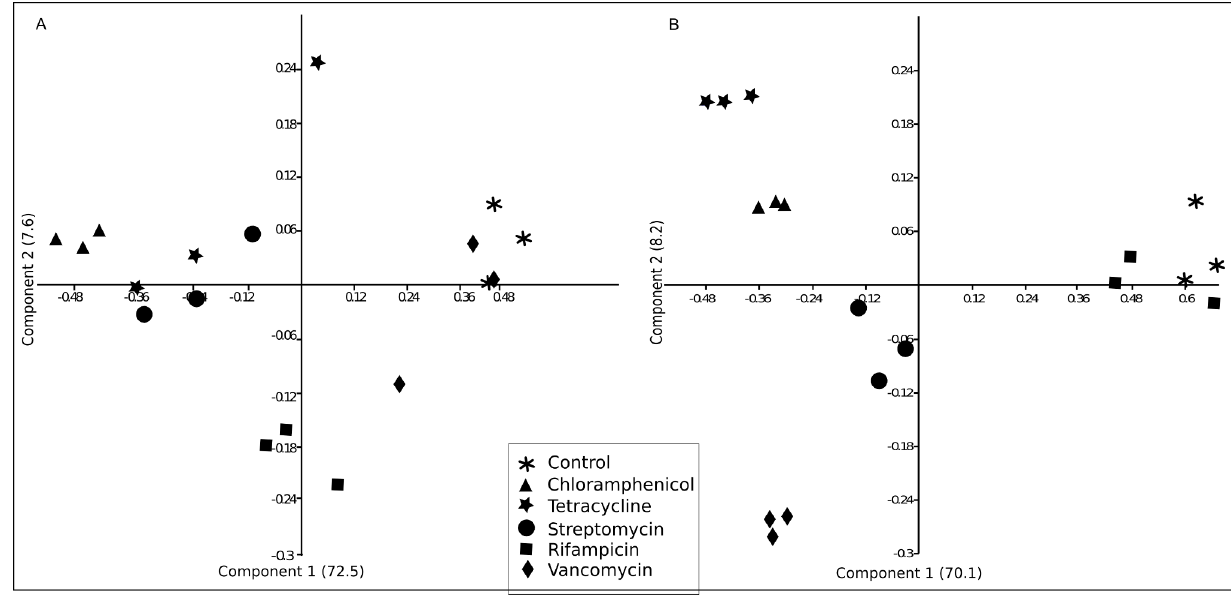
Figure 1. Principal components analysis of nutrient use profiles of Streptomyces isolates. Principal components analysis of nutrient use profiles for Streptomyces isolates 1232-2 and Mont3-8 in the presence and absence of SICA. Growth was evaluated on Biolog SF-P2 plates; each treatment was replicated three times. The percent variation in nutrient use explained by each axis is shown in parentheses.